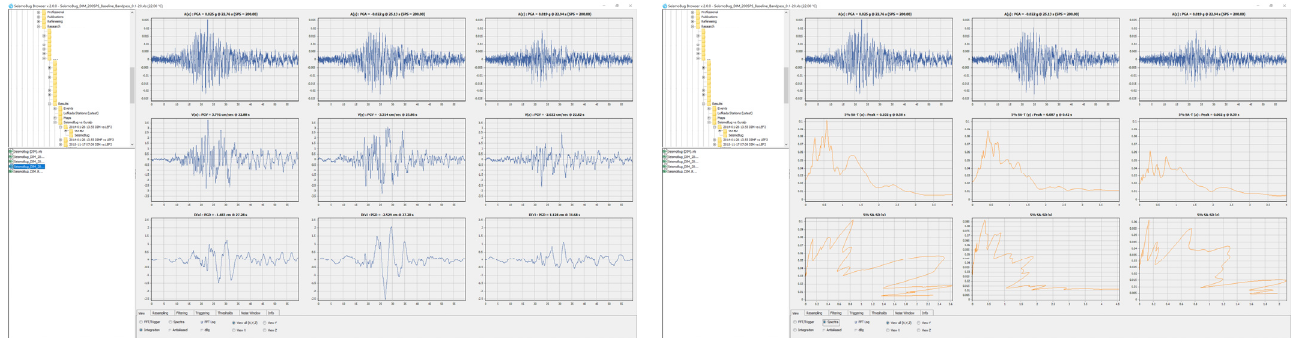
Figure 4. Device validation: ( a ) Seismic table test setup ( b ) Record comparison in time and frequency domain for a 5 Hzharmonic signal ( c ) PSD levels for a 60 s of ambient noise measurement.